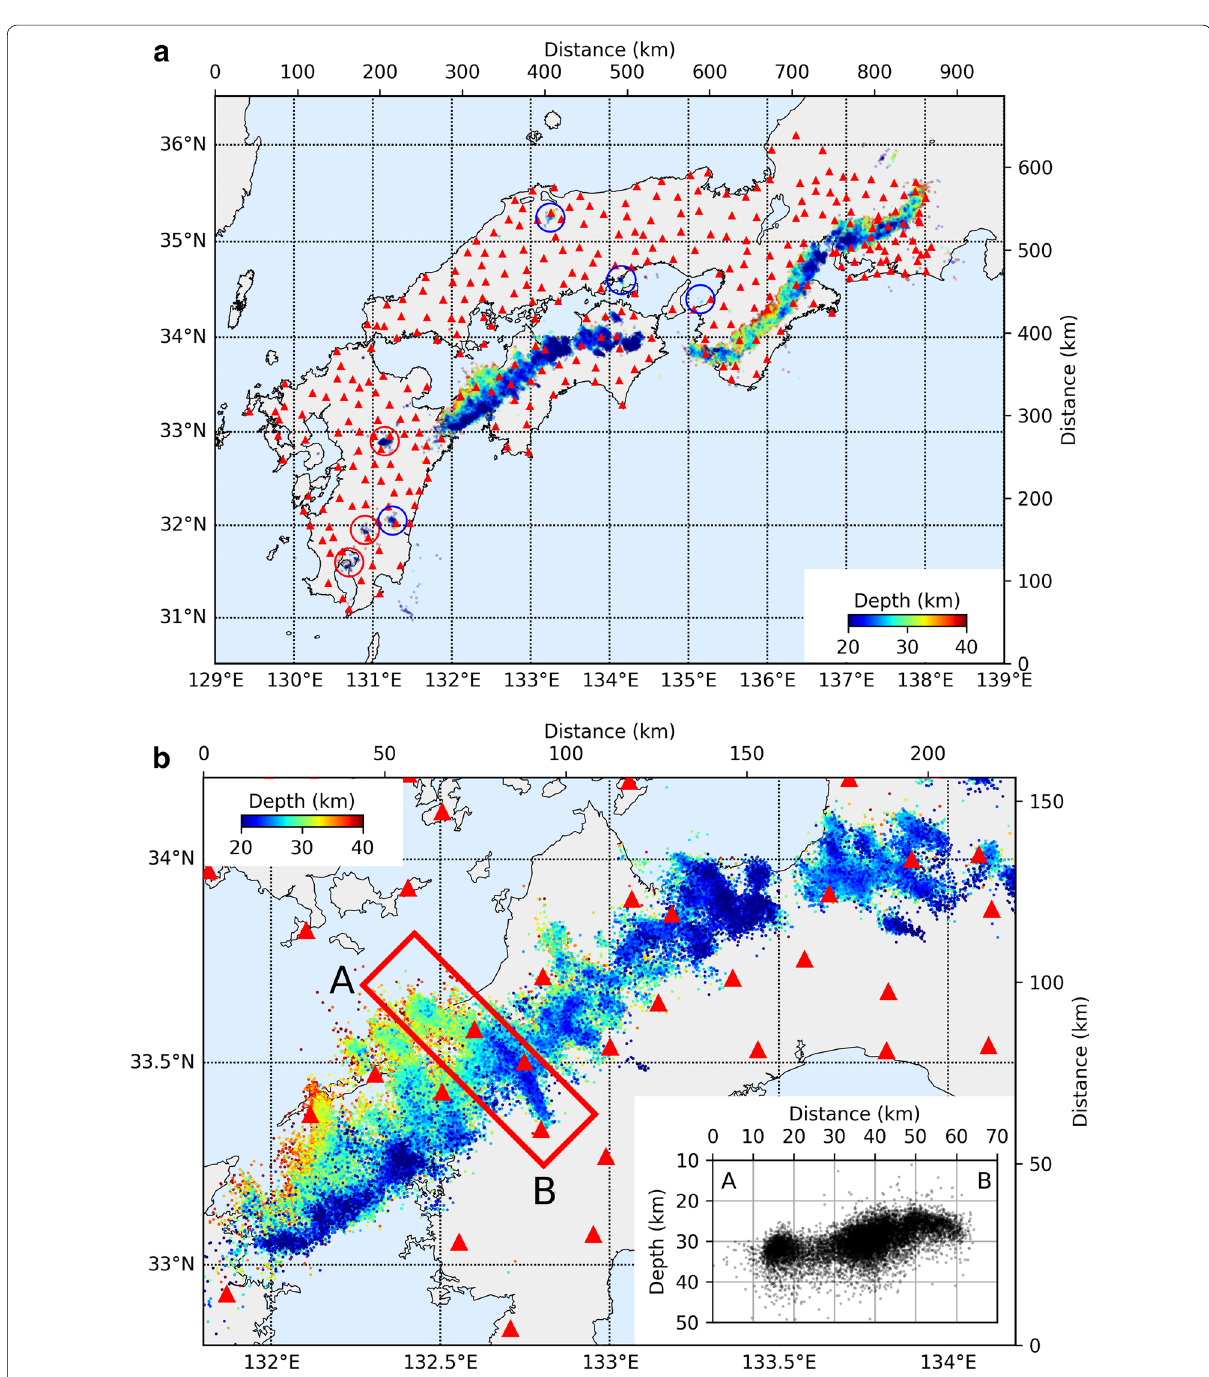
Fig. 6 Tremor locations using our proposed location method and the seismic station coverage for a western Japan and b western Shikoku. The dots show the located tremor hypocenters, with the colors indicating their depths. The red triangles show the Hi-net seismic stations. The red circles show the volcanic tremors. The blue circles show the tremors occurring outside of the tremor concentrated band, in Kyushu, Tottori, Okayama, and Osaka Bay. The inset figure in b shows a cross section of tremors located within the red